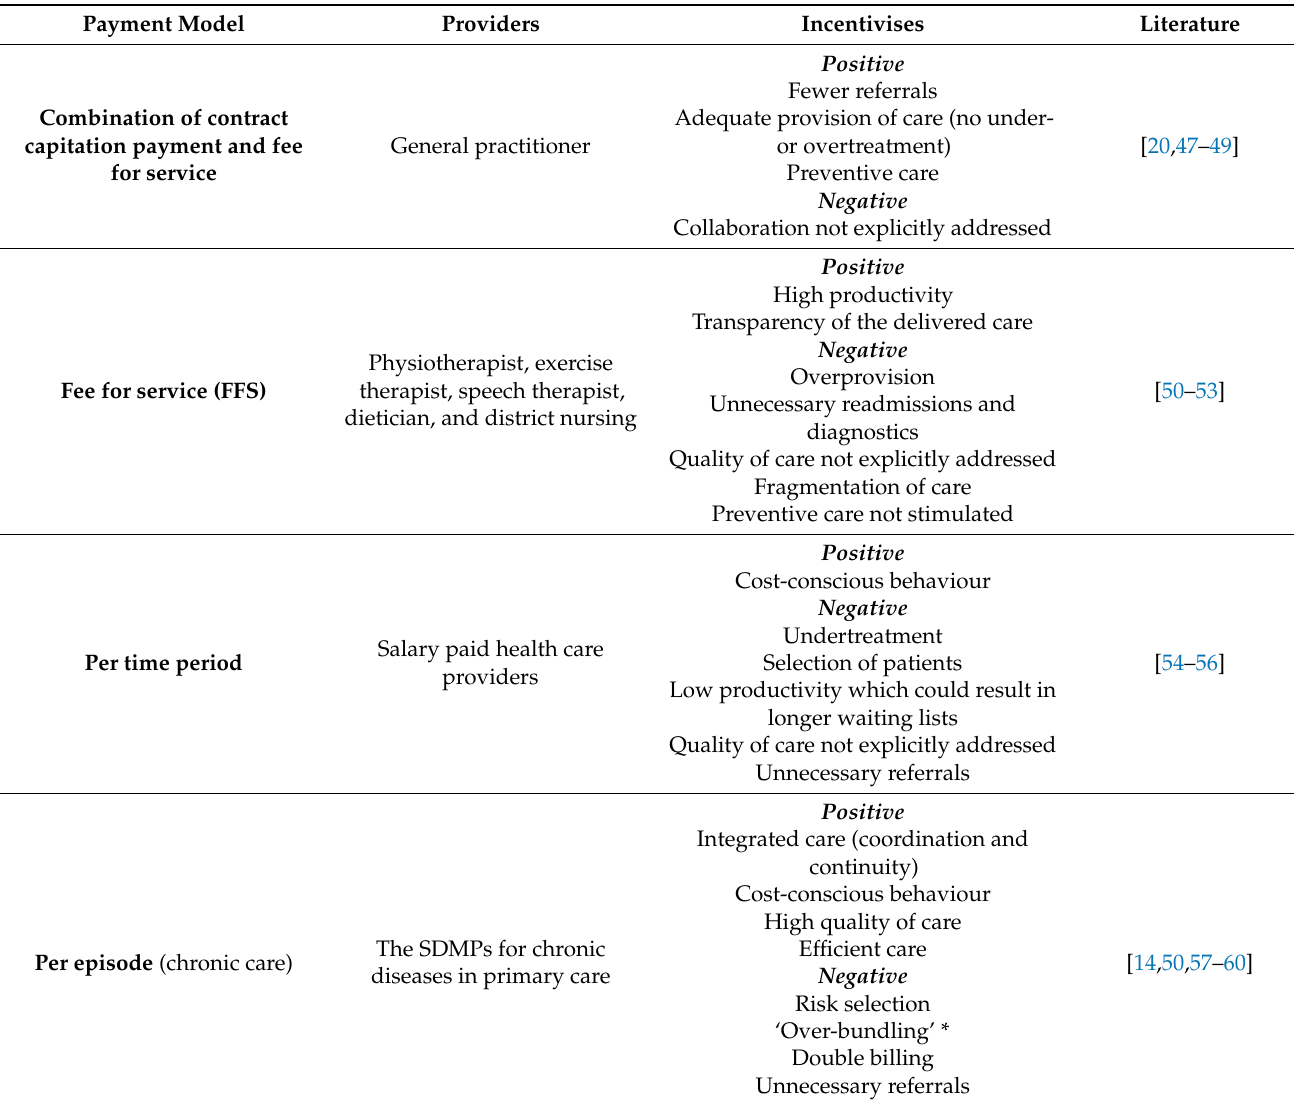
Table 2. Current Dutch payment models based on the typology of Quinn (2015) [35] and the HCP- LAN (2017) [36] and their (financial)